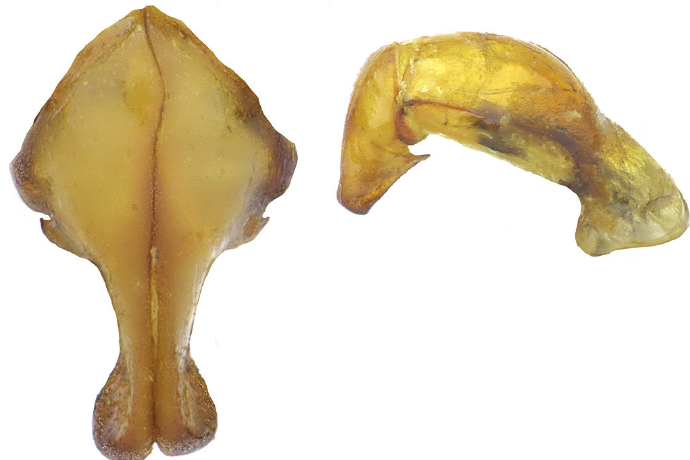
Figure 4. Parameres, caudal and lateral views, of Chalepides pantanalensis Ratcliffe & Seidel, sp. nov.